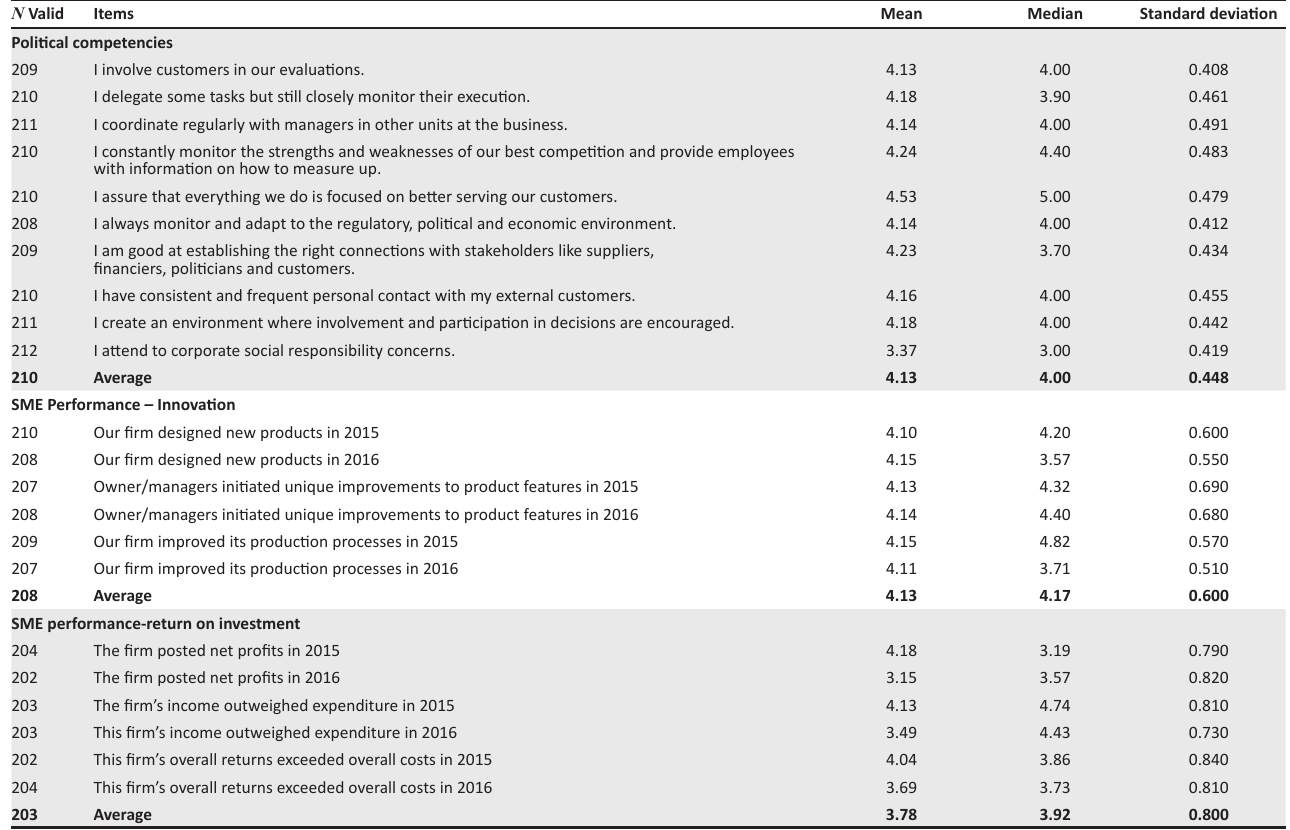
TABLE 2: Managerial political competencies of owners or managers and firm